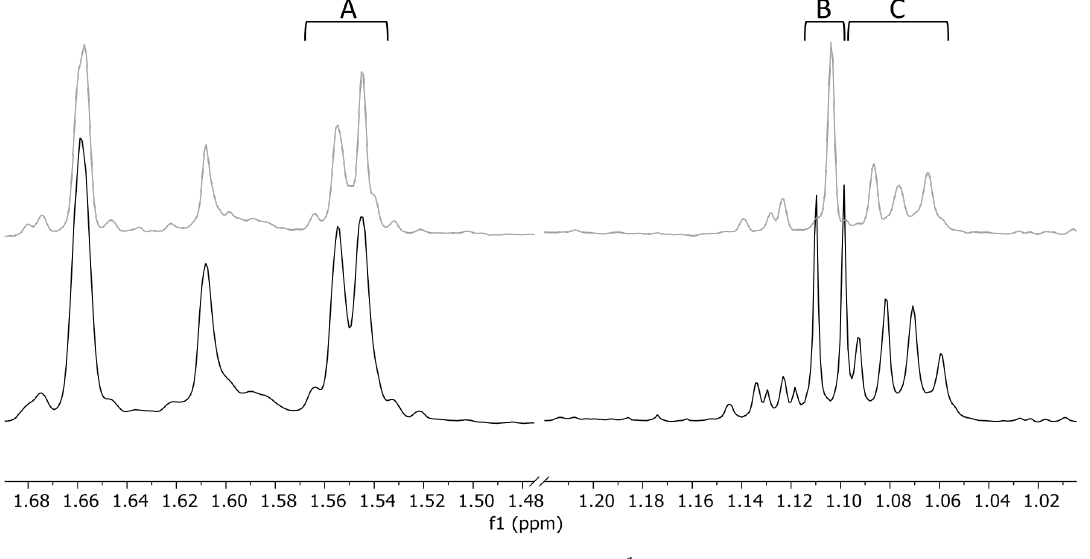
Figure 8. Regions of interest ( A – C ) in the conventional 1 H-NMR spectrum (black) of Hypericum canariense where the PSYCHE spectrum (grey) helps to identify signals and their multiplicity.